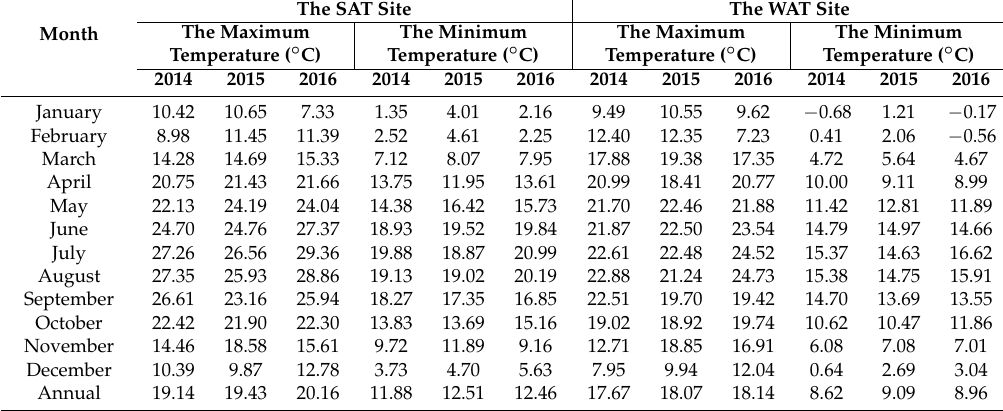
Table 1. The maximum temperature and minimum temperature in the SAT and WAT sites from 2014 to 2016.